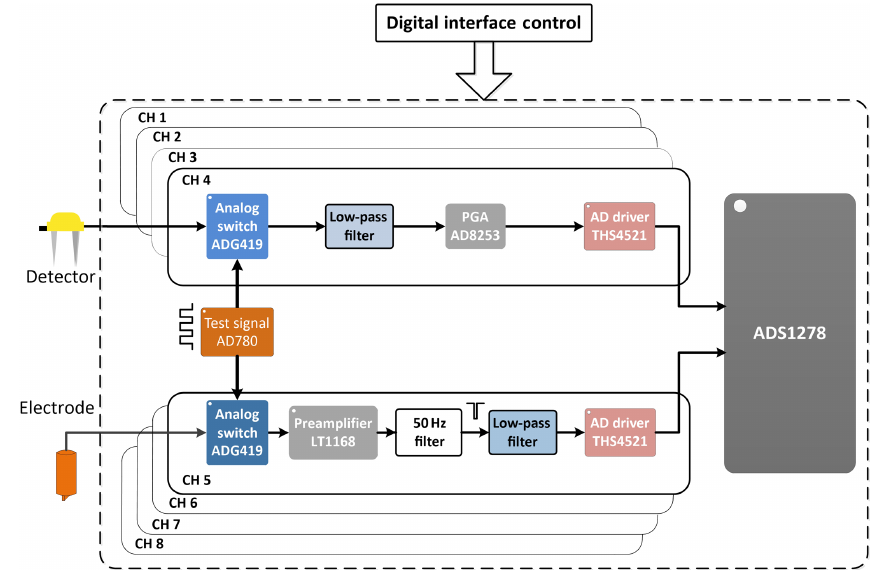
Figure 2. A block diagram of the sampling board.